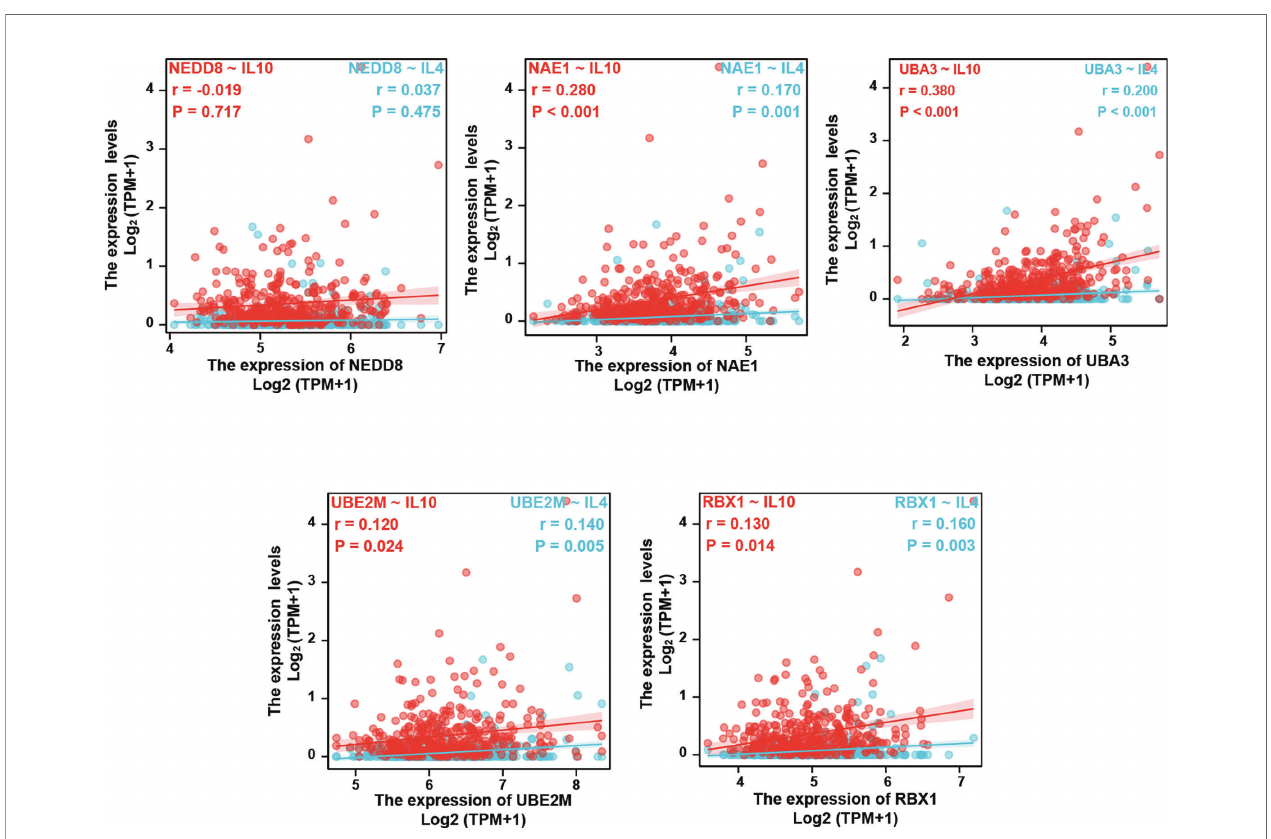
FIGURE 4 | Neddylation pathway positively correlates with Th2-released cytokines